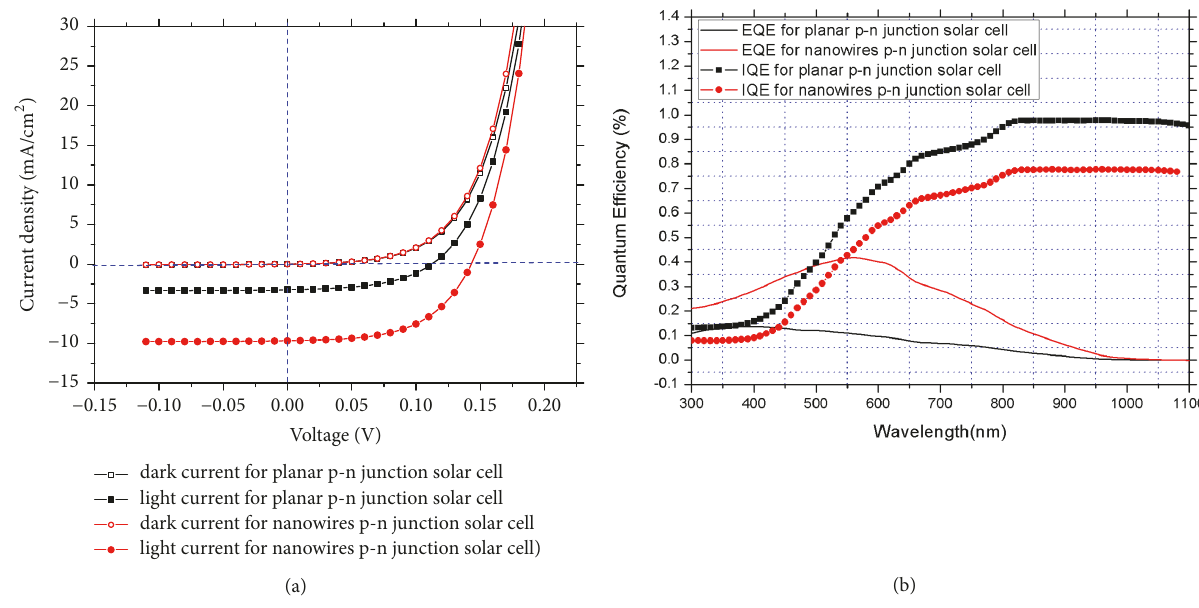
Figure 4: Photovoltaics performance of the planar and nanowires p-n junction solar cell: ( a ) J-V curves of planar p-n junction on 2 𝜇 m thick substrate; ( b ) EQE and IQE of 4 𝜇 m nanowires radial core-shell junction on 2 𝜇 m thick